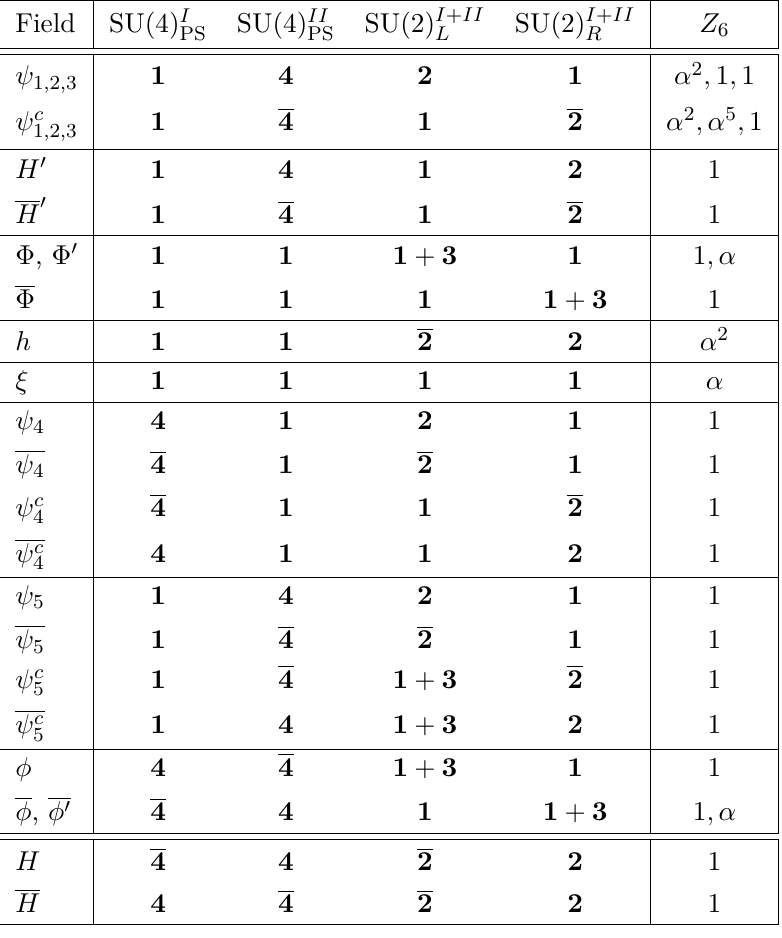
Table 2 . Under the subgroup G 4422 the fields in table 1 transform as